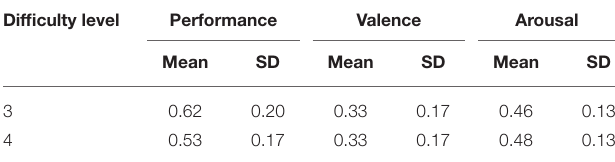
TABLE 2 | Descriptive analysis of performance, valence, and arousal.